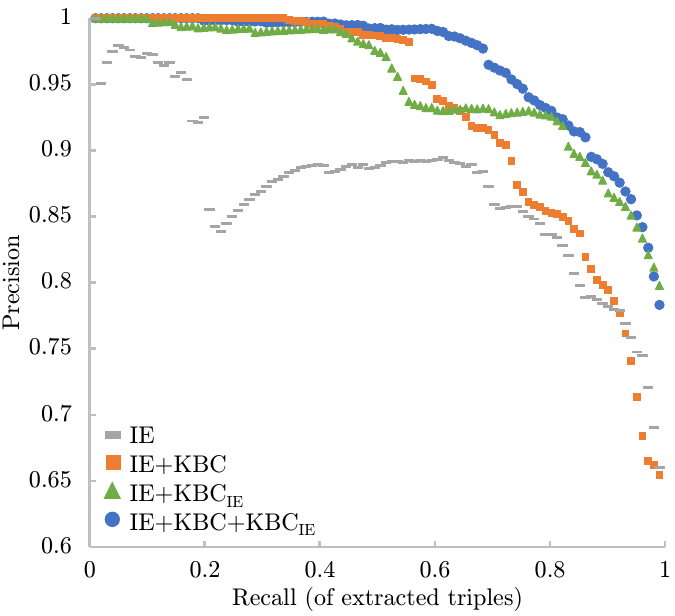
Figure 6. Precision recall curves for